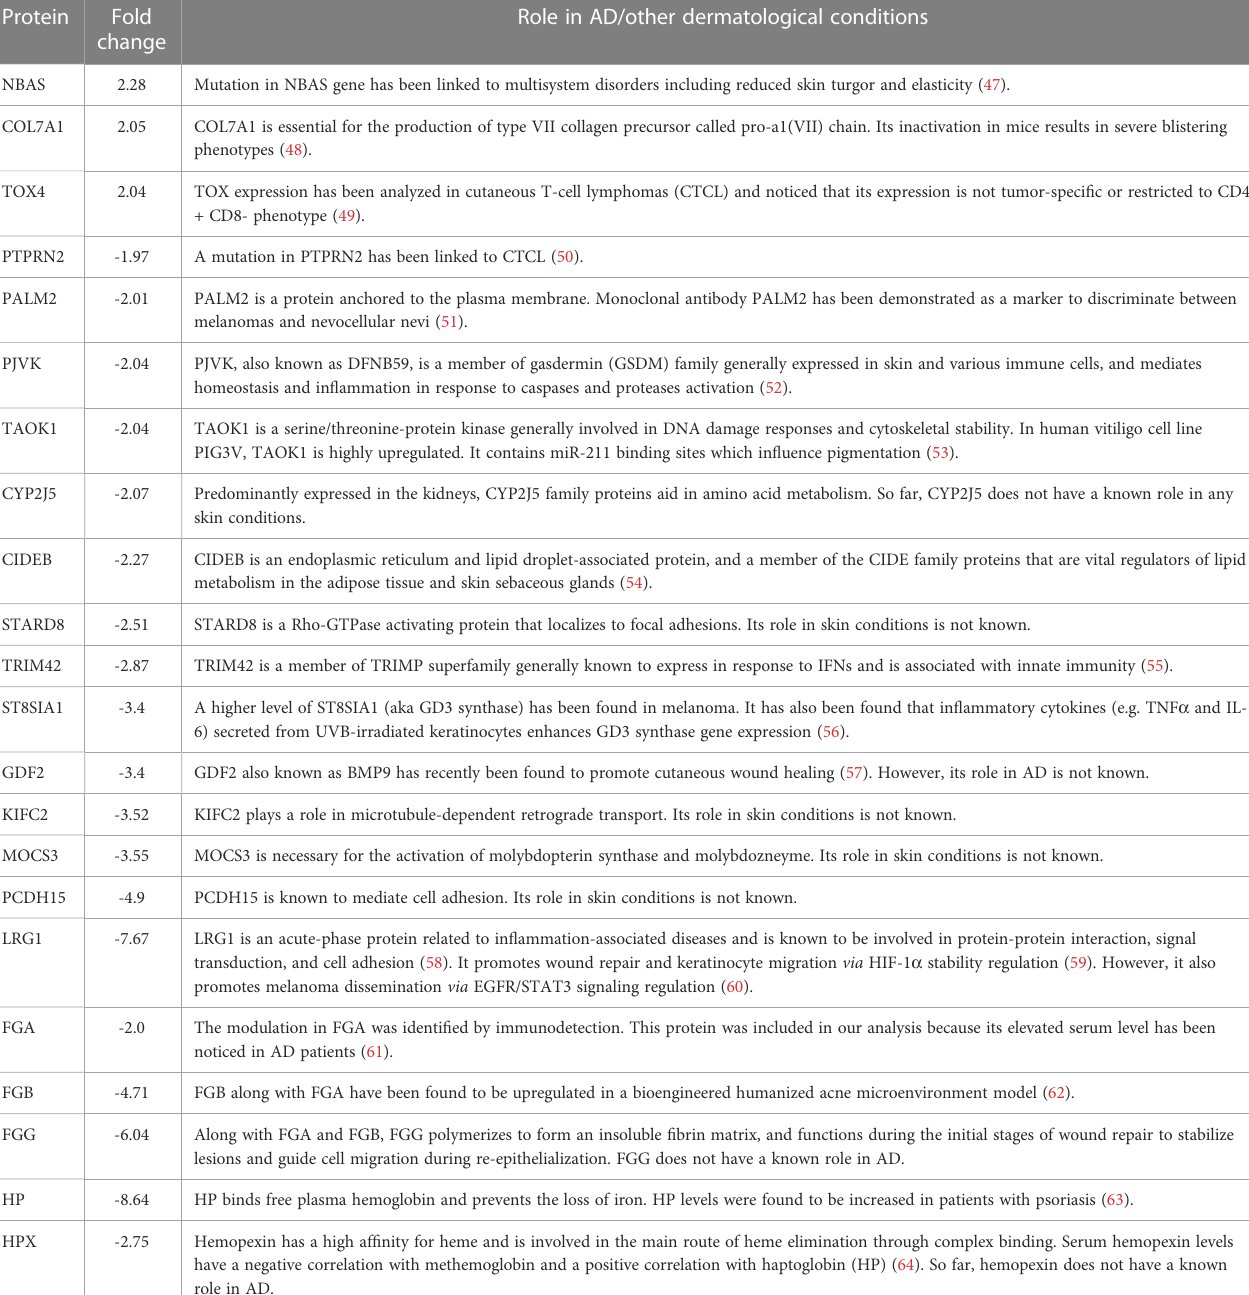
TABLE 3 A literature analysis of proteins signi fi cantly affected by 5% grape powder supplementation in NC/NgaTndCrlj mice. Protein Fold change